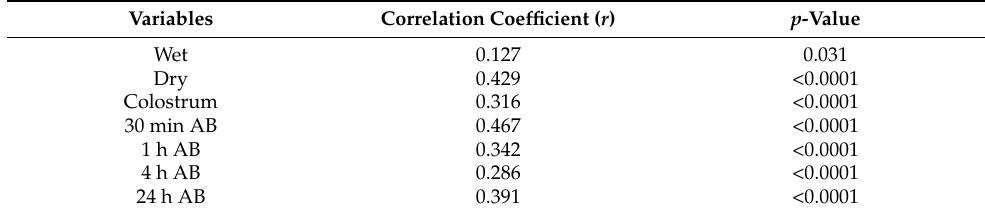
Table 12. Significant correlations in the T thermal window temperatures of newborn puppies and the weight of the dams at different times: wet (with amniotic fluid), dry (once the puppy was rubbered), colostrum (after colostrum intake and separated from mother’s teat), 30 min AB, 1 h AB, 4 h AB, and 24 h